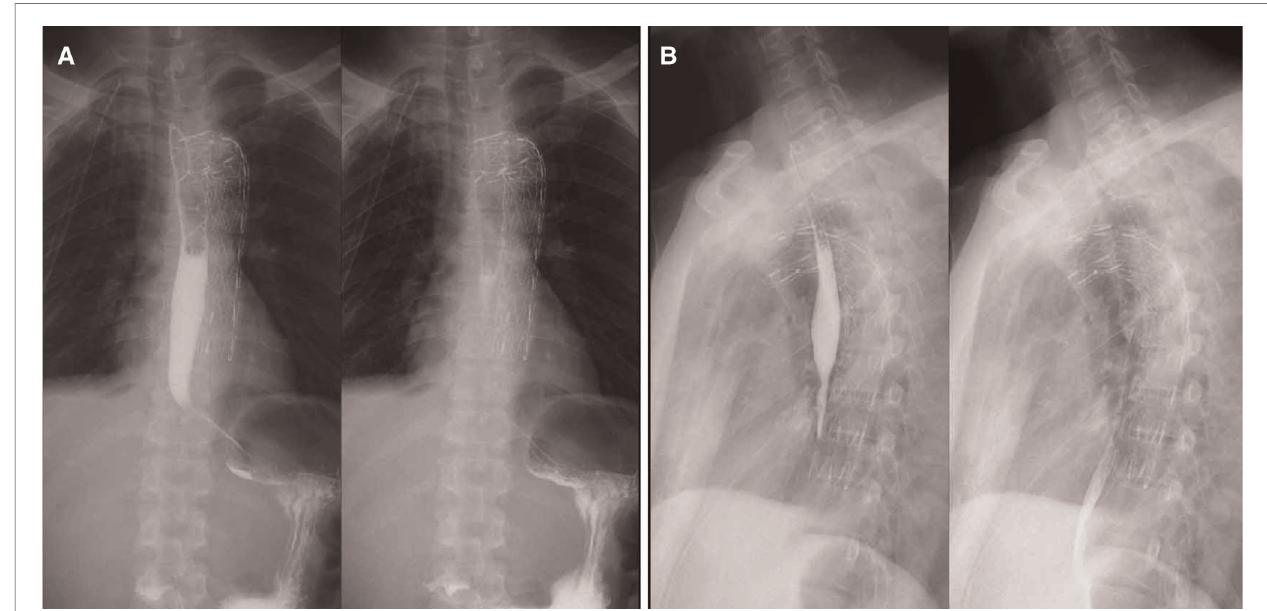
FIGURE 3 | Postoperative upper digestive tract iodine angiography. ( A , B ) Esophageal walls were intact, without contrast agent